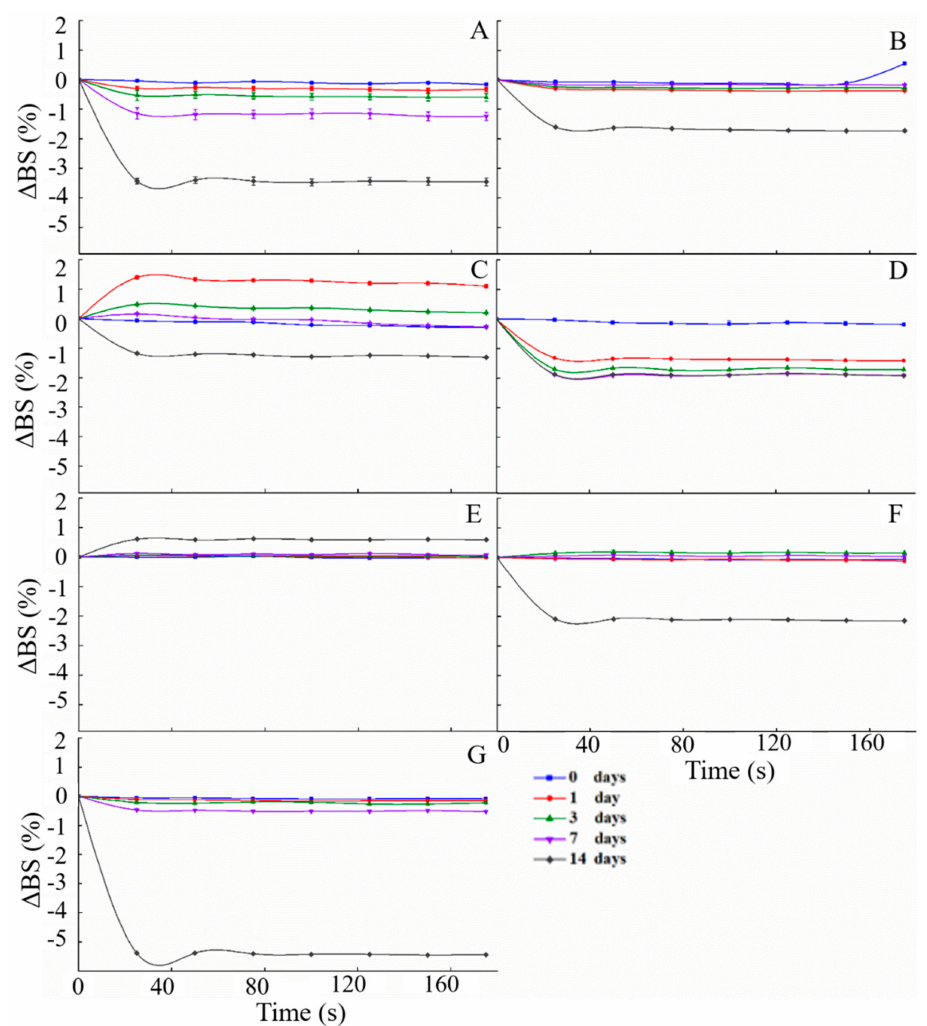
Figure 7. Changes in the backscattered light (BS) curves of di ff erent emulsifiers in the emulsion during storage. ( A ) Control group; ( B – G ) emulsions with added CAEM, SDM, PGFE, SMG, LC, and GA,